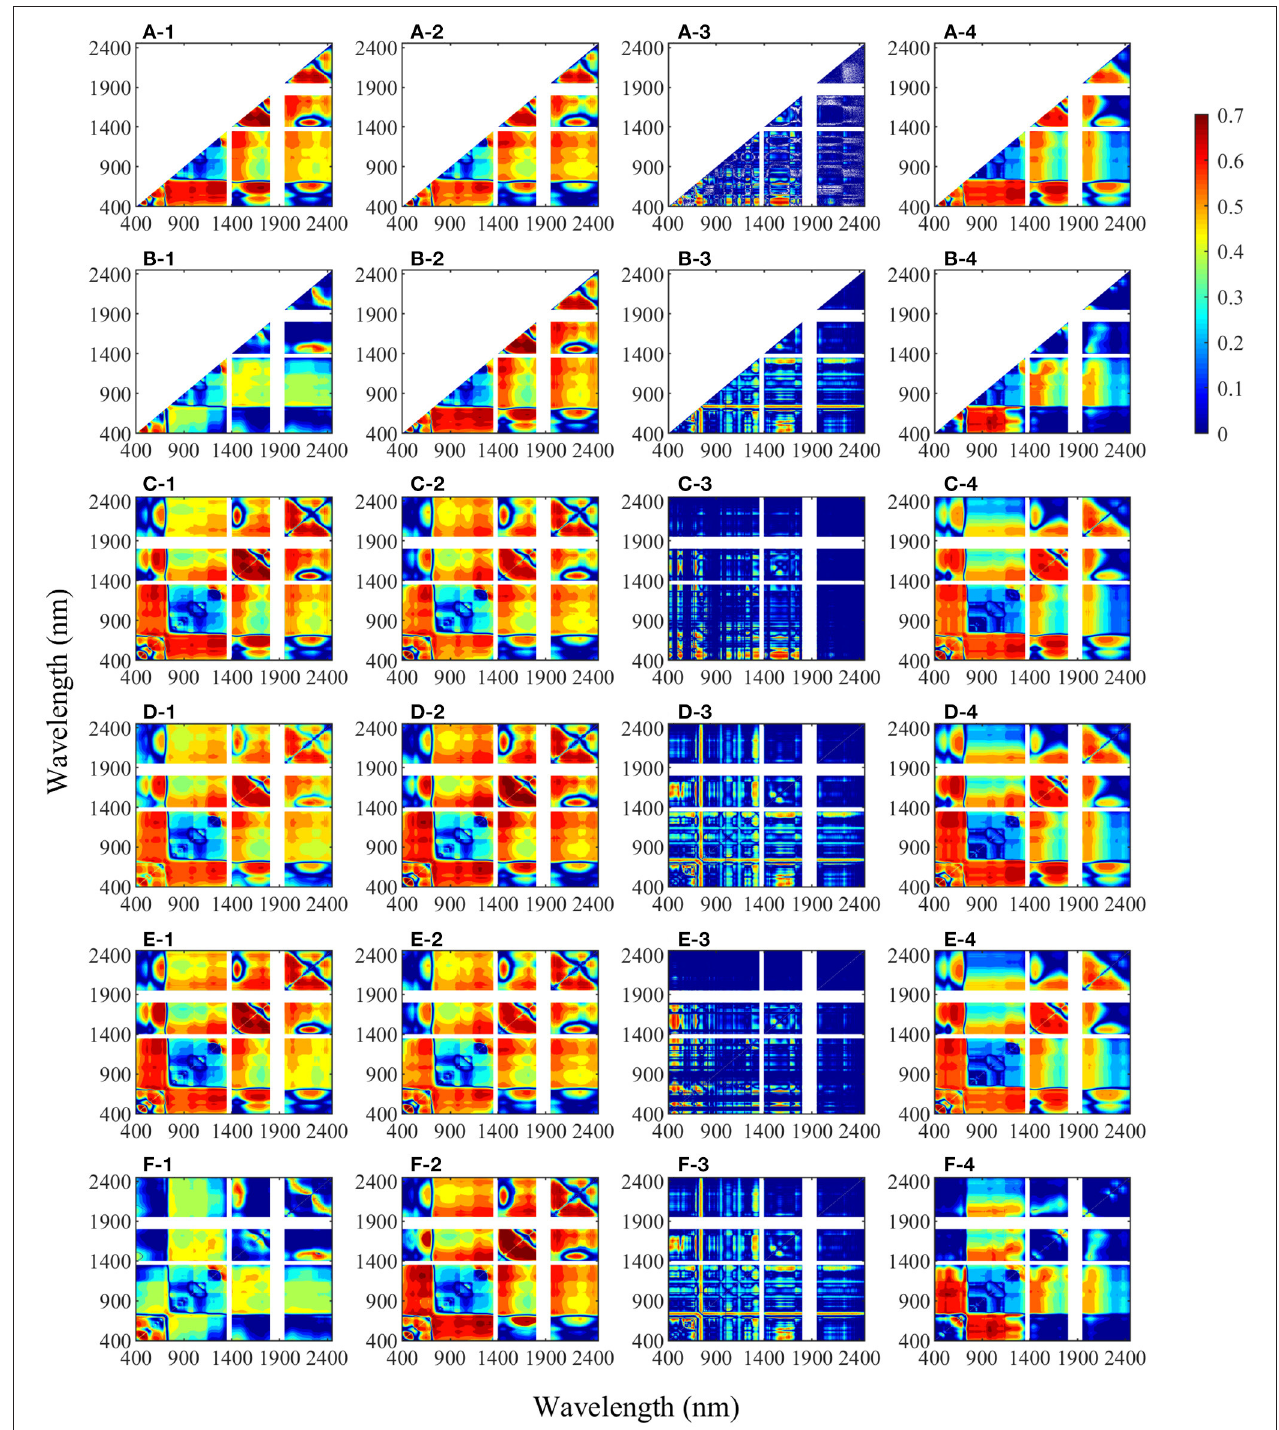
FIGURE 5 | Coefficient of determination ( R 2 ) between leaf nitrogen accumulation and two-band combined spectral indices (A) NDSI, (B) DSI, (C) RSI, (D) SASI, (E) CSI, and (F) MCSI, which were calculated form all possible two bands with different transformation methods in winter wheat ( n = 160). (1: original reflectance, 2: the logarithm of the reserved reflectance, 3: the first derivative reflectance, and 4: continuum removal spectrum).